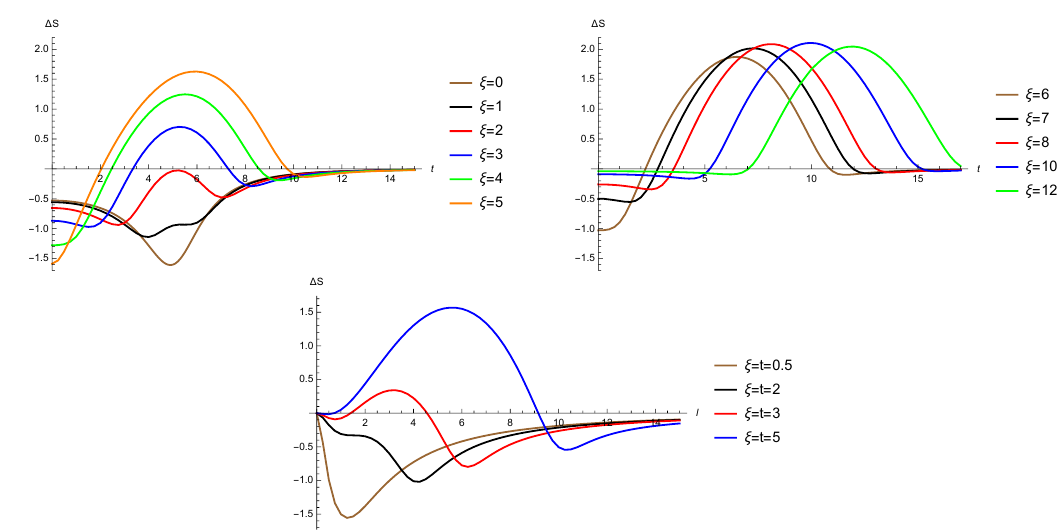
Figure 10 : Left and right: time dependence of ∆ S for a disk-shaped subregion of radius ) = ( ξ, 0) for different values of ξ . For large ξ , the maximum is l = 5 centered at ( x , x 1 2 reached for t ≈ ξ . Bottom: plot of ∆ S as a function of l for a translated disk-shaped subregion, for various values of t = ξ . Numerical values α = 1 , A = 1 have been H